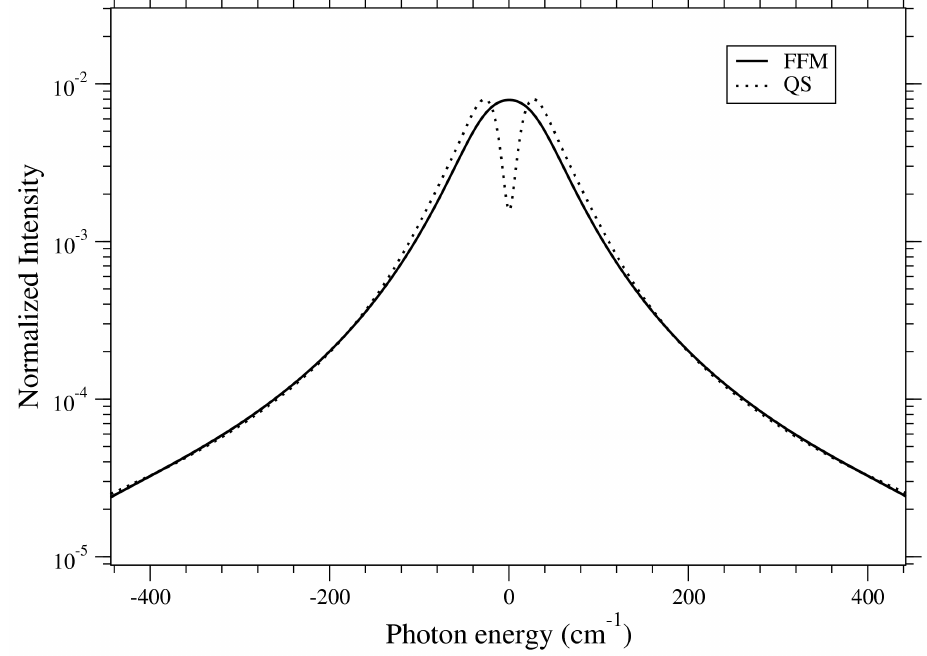
Figure 5. Lyman- β line shapes of hydrogen at T = 100 eV and N e = 10 17 cm − 3 . The calculations were performed with the ZEST code either in the quasi-static approximation (QS) or accounting for ion dynamics effects (FFM), assuming a Holtsmark microfield distribution. The Doppler effect has been omitted for the comparison (electron broadening